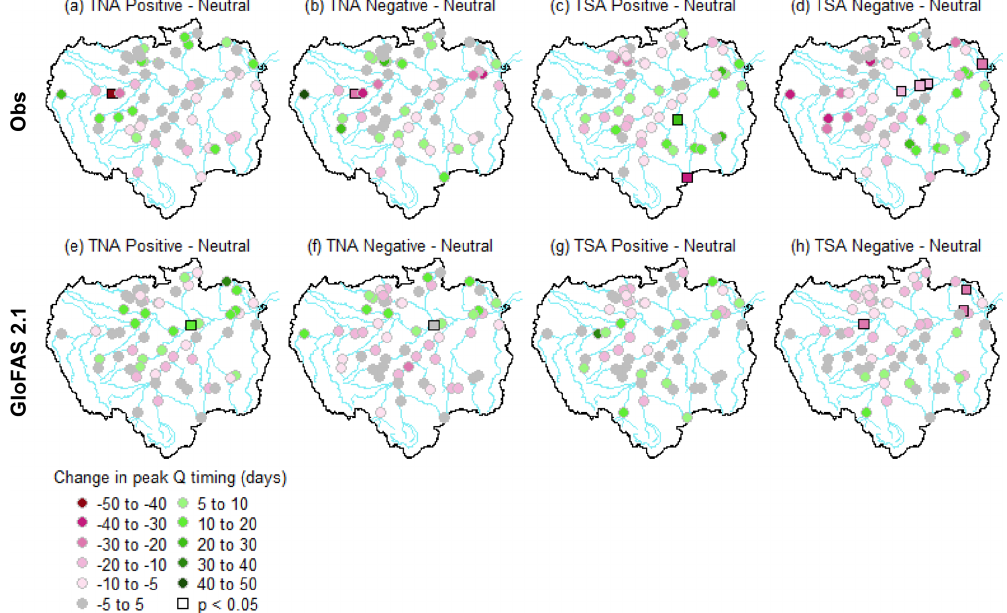
Figure 7. Average change in the timing of observed and simulated annual peak river flows between different phases of tropical Atlantic indices. (a, c, e, g) Positive with respect to neutral years. (b, d, f, h) Negative with respect to neutral years. Panels (a–d) represent changes for observations and panels (e–h) show changes for GloFAS 2.1 streamflow reanalysis data. Pink (green) points represent where flood peaks occur earlier (later) compared to neutral conditions. Significant results at the 95% confidence level are denoted using a square (i.e. p < 0 .